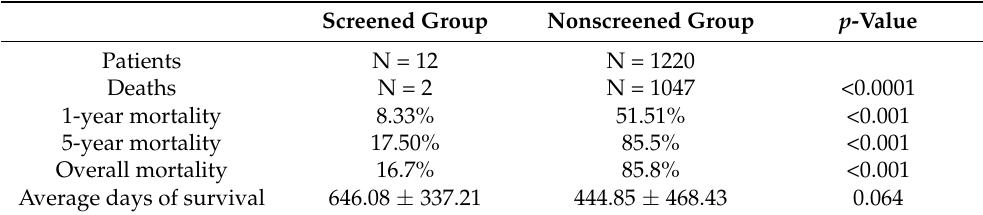
Table 4. Clinical outcomes and mortality profiles of smokers with lung cancer according to screening status.